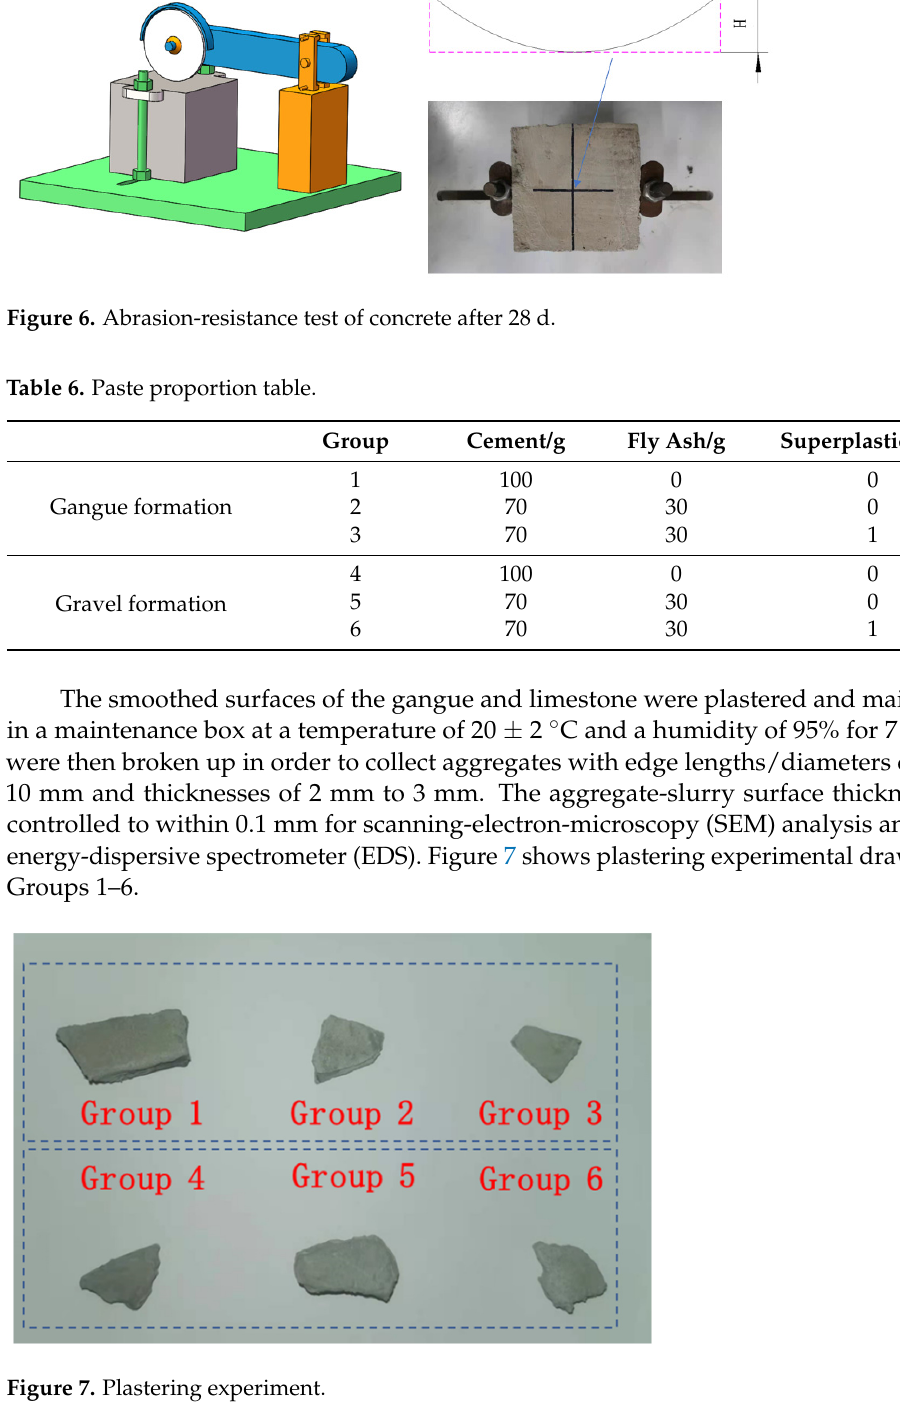
0 Table 8. Experimental results. Groups